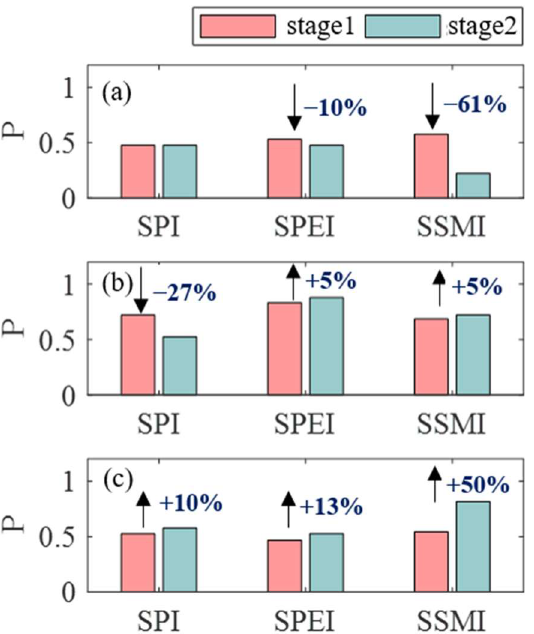
Figure 9. Comparison of conditional probability of cropland vulnerability between stage 2 and stage 1 under light drought stress: ( a ) spring, ( b ) summer and ( c ) autumn.